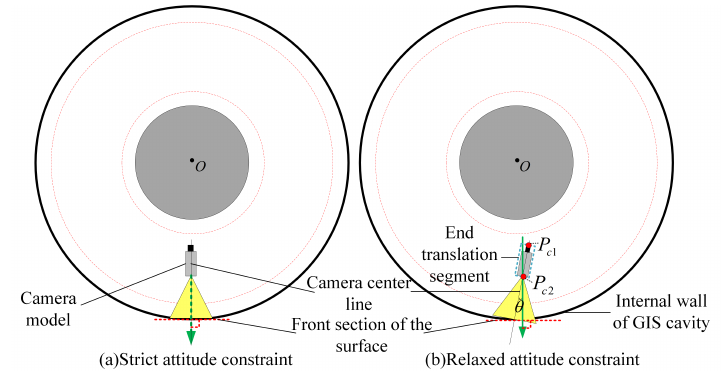
Figure 5. The attitude constraint